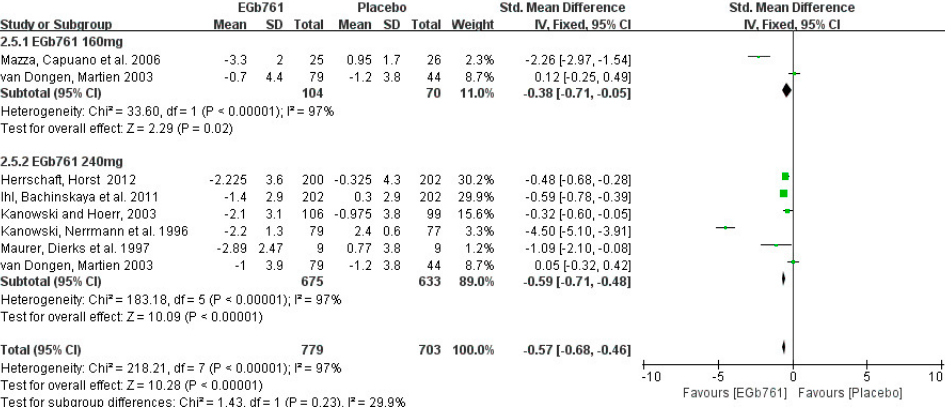
Figure 6. Meta-analysis of all patients in SKT. The square area represents the weight assigned to the study in the meta-analysis. The horizontal line represents the 95% confidence interval. Figure 7. Forest plot of comparison: meta-analysis of AD patients taking either placebos or GBE in SKT, at doses of 240 mg/d, and below 240 mg/d. The square area represents the weight assigned to the study in the meta-analysis. The horizontal line represents the 95% confidence interval.